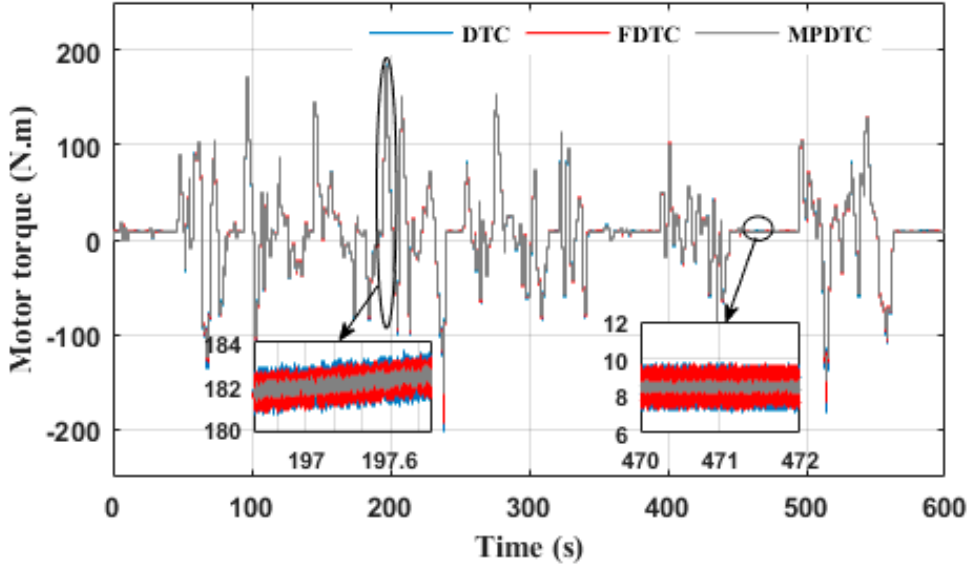
Figure 15. Electromagnetic torque of the PMSM under di ff erent control techniques with NYCC driving cycle.